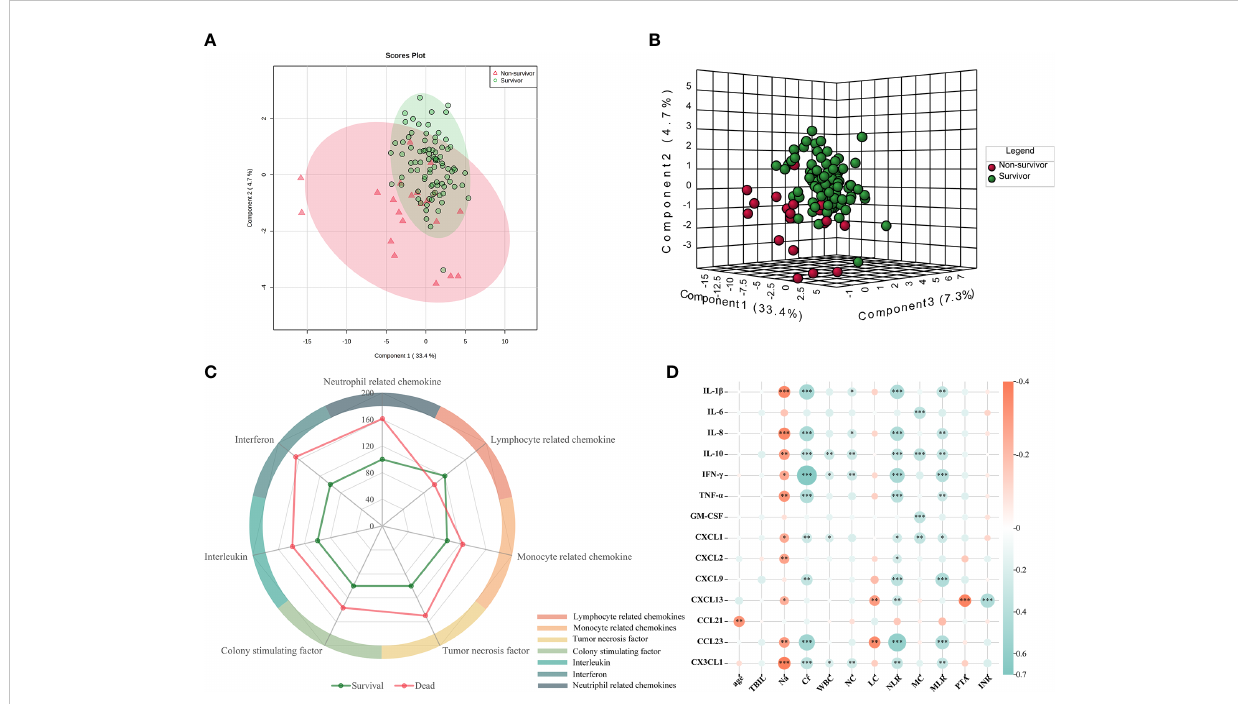
FIGURE 1 Comparison of the serum cytokines between non-survivors and survivors. (A, B) Principal component analysis (PCA) and partial least squares discriminant analysis (PLS-DA) of the cytokine expression pro fi les in survivors and non-survivors. The red circle represents the multiplex cytokine expression for non-survivors, while the green color depicts survivors. (C) Radar map of the six classi fi cation scores in non-survivors ( n = 21) compared with those in survivors ( n = 86). The radius represents the percentage of expression. Interleukins: IL-1 b , IL-2, IL-4, IL-6, IL-10, and IL-16; monocyte-associated chemokines: CCL2, CCL3, CCL7, CCL8, CCL13, and CCL15; neutrophil-related chemokines: CXCL1, CXCL2, CXCL5, CXCL6, CXCL8, and CXCL10; and lymphocyte-related chemokines: CCL1, CCL2, CCL17, CCL21, CCL22, and CCL23. (D) Correlation heatmap of the